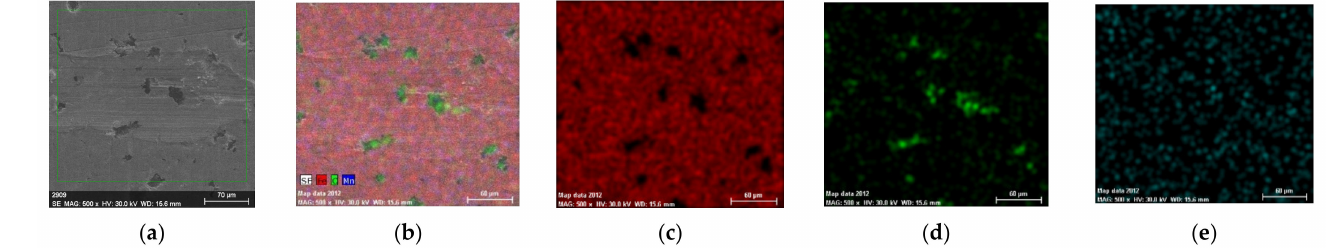
Figure 9. Scratch test for uncoated nodular cast iron SEM images ( a – e ).